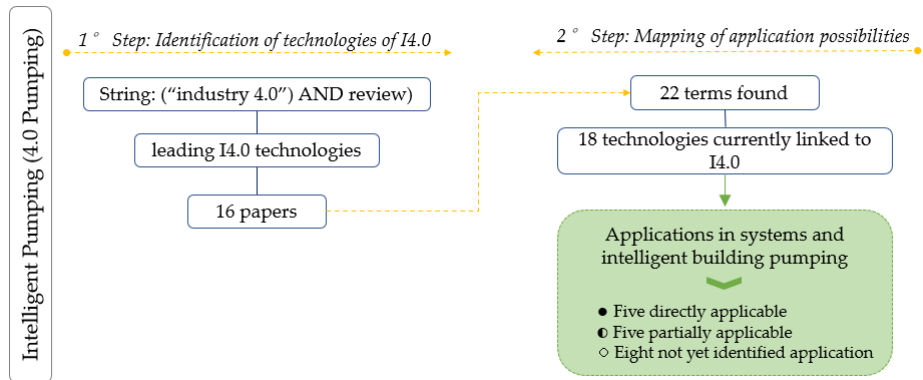
Figure 1. Flowchart of the methodological steps of the study.